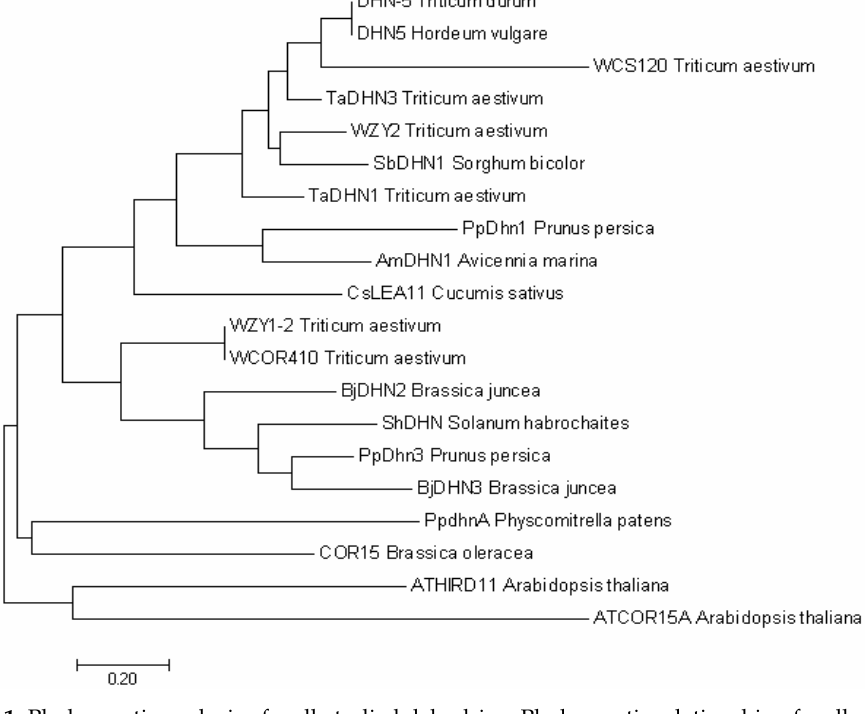
Figure 1. Phylogenetic analysis of well-studied dehydrins. Phylogenetic relationship of well-studied dehydrins. The bootstrapped tree with 1000 replicates was constructed using MEGA 7 tools.